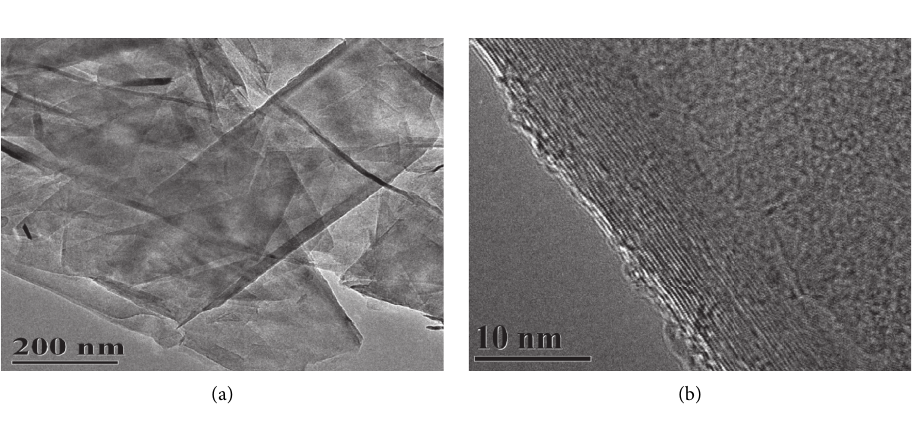
Figure 1: SEM of GN.